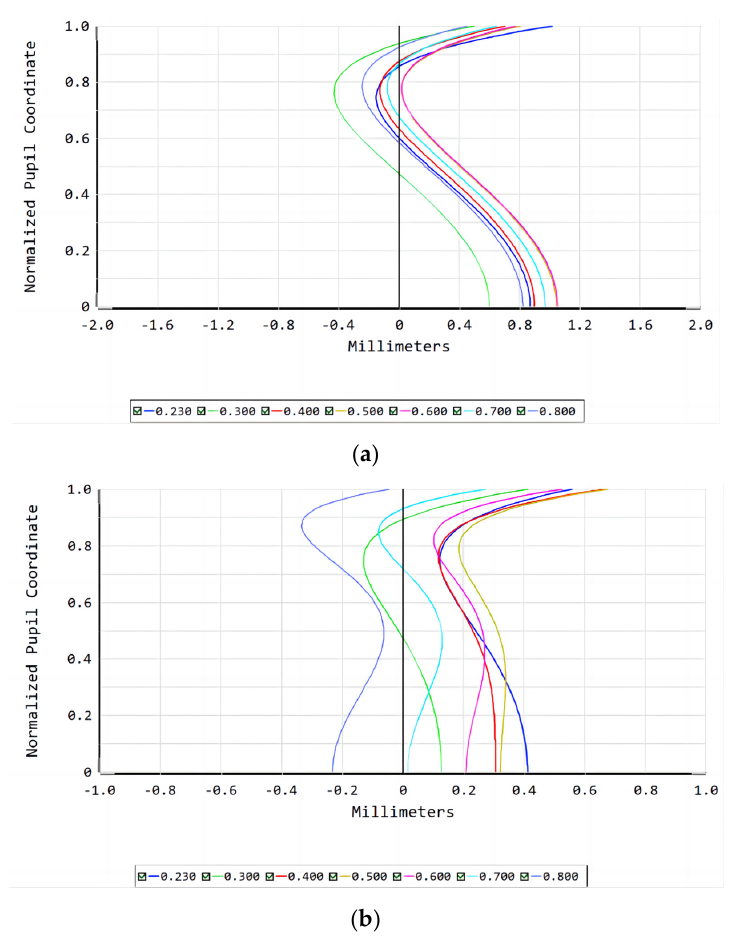
Figure 9. Longitudinal aberration of the ( a ) refractive lens system; ( b ) refractive/diffractive hybrid lens system.